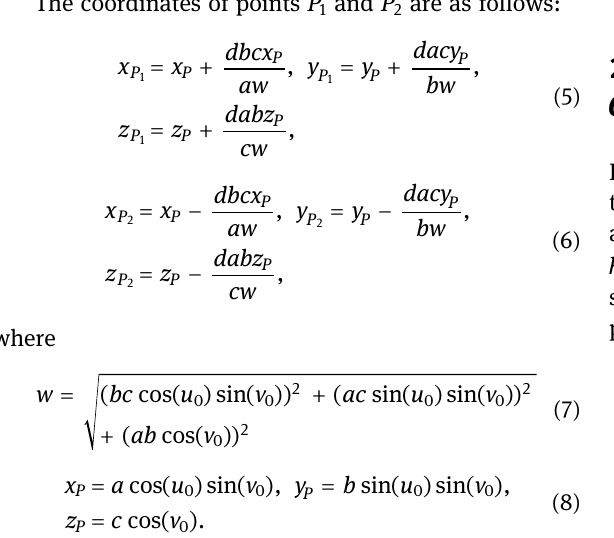
( Figure 4 ( b and c )) . The green line segments ( perpendicular to the red surface S u v , ( ) ) , one end of which is ( in Figure 4 ( a )) below the OXY plane, were trimmed ( in Figure 4 ( b and c )) at points ( for w dab , y , z P with the coordinates x P = ) . The frag - P 2 2 2 c ment of the ( blue ) surface ( mesh ) S u v off , d 2 ( ) was reduced